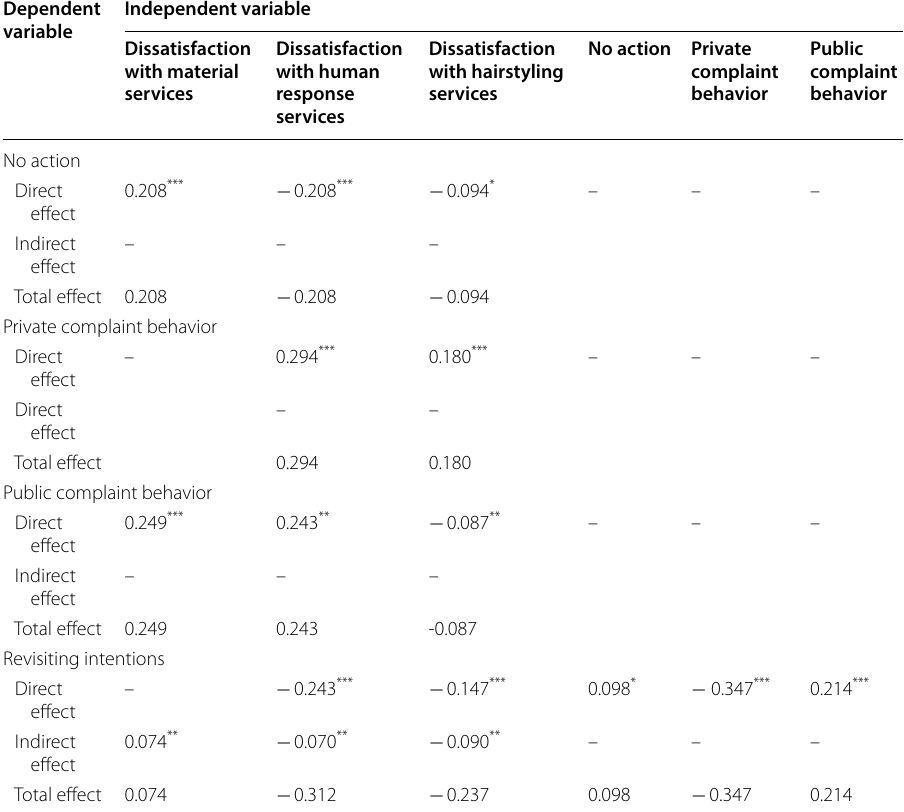
Table 4 Direct effect, indirect effect and total effect